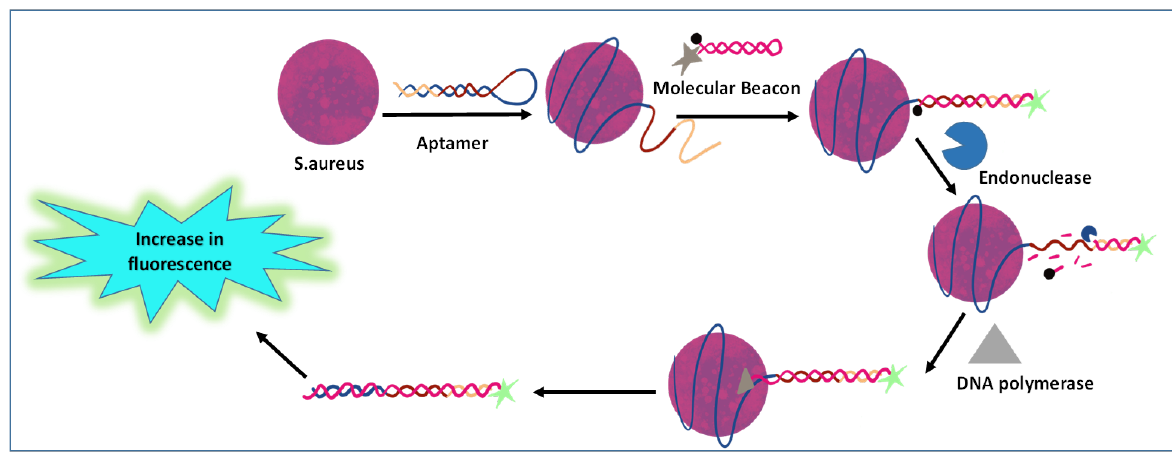
Figure 4. Schematics representing detection of Staphylococcus aureus ( S. aureus ) using specific aptamer, a fluorescent molecular beacon, and signal amplification. The chimera aptamer sequence forms a hairpin structure with aptamer sequence of S. aureus . In the presence of bacterial pathogens (i.e., S. aureus ), it becomes bound to aptamer region of chimera sequence, which results in opening of hairpin structure and unlocking of molecular becon, restoring the fluorescence [98].